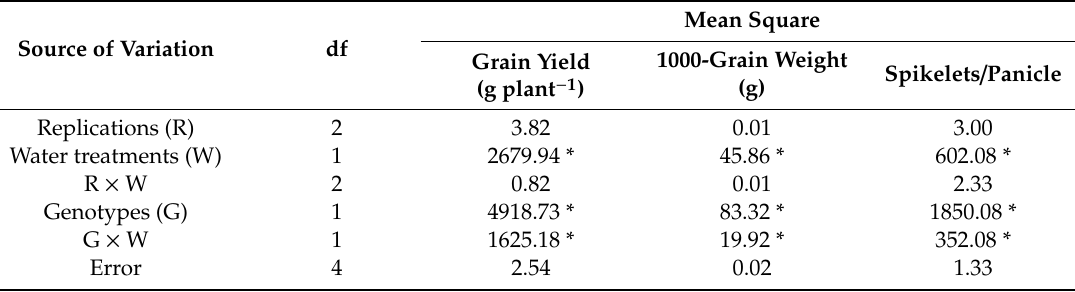
Table 6. Analysis of variance for agronomical traits.